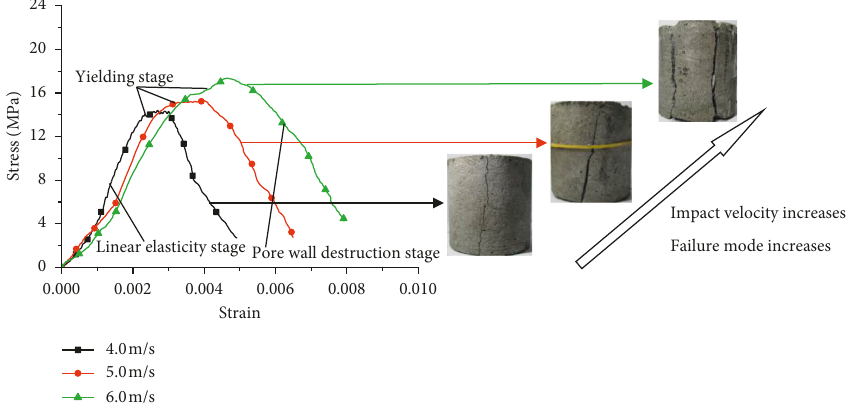
Figure 12: Foam concrete with fly ash stress-strain curve at 1,200kg/m 3